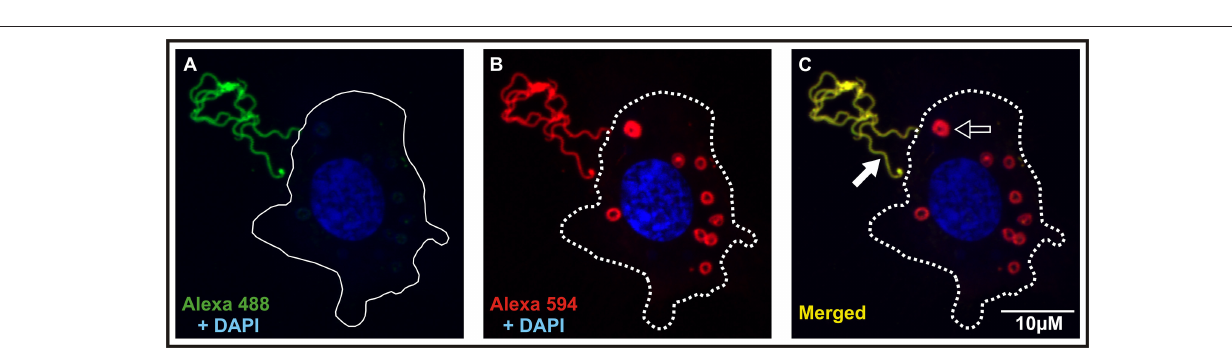
complexes (pattern-recognition receptor) on the surface of pathogens (Ng et al., 2007), are absent from the tick genomes. FRePs are widely distributed among arthropods in different numbers and domain combinations, playing a